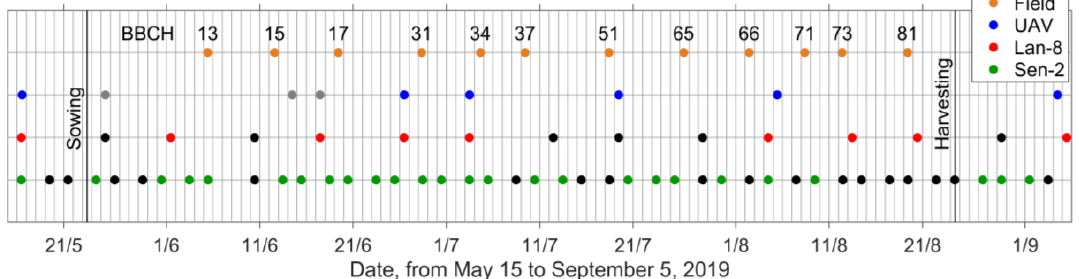
Figure 3. The calendar of survey activities and satellite passages. Grey and black dots represent surveys or passages that for any reason resulted in not useful images (cloud cover, hazy sky at high altitude or technical problems).